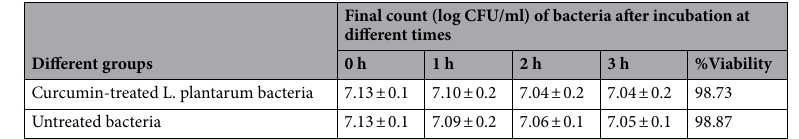
Table 1. Curcumin-treated vs untreated L. plantarum survival rates at different time intervals (0, 1, 2, 3 h) following incubation at low pH (pH = 3).